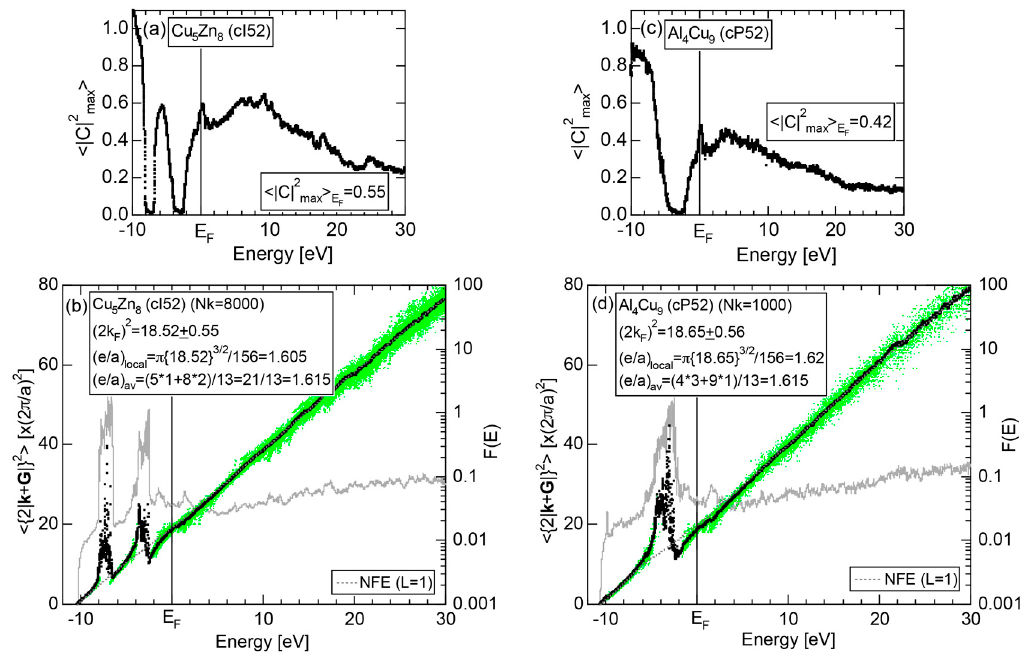
Figure 34. ( a ) C max2 and ( b ) Hume-Rothery plot for Cu 5 Zn 8 (cI52) [11]. Respective data in ( c , d ) for Al 4 Cu 9 (cP52). Symbols in ( b , d ) refer to the TH-HR (Tetrahedron-Hume-Rothery) data points (black), dimensionless variance F ( E ) (grey), NFE curve ( L = 1) (dotted grey), and data points satisfying the condition ∑ (cid:12) (cid:12) C k i + G p pj ≥ 0.2 (green dots). The NFE curve in ( b , d ) is intentionally shown with less visible grey dots, since the local reading method is used.